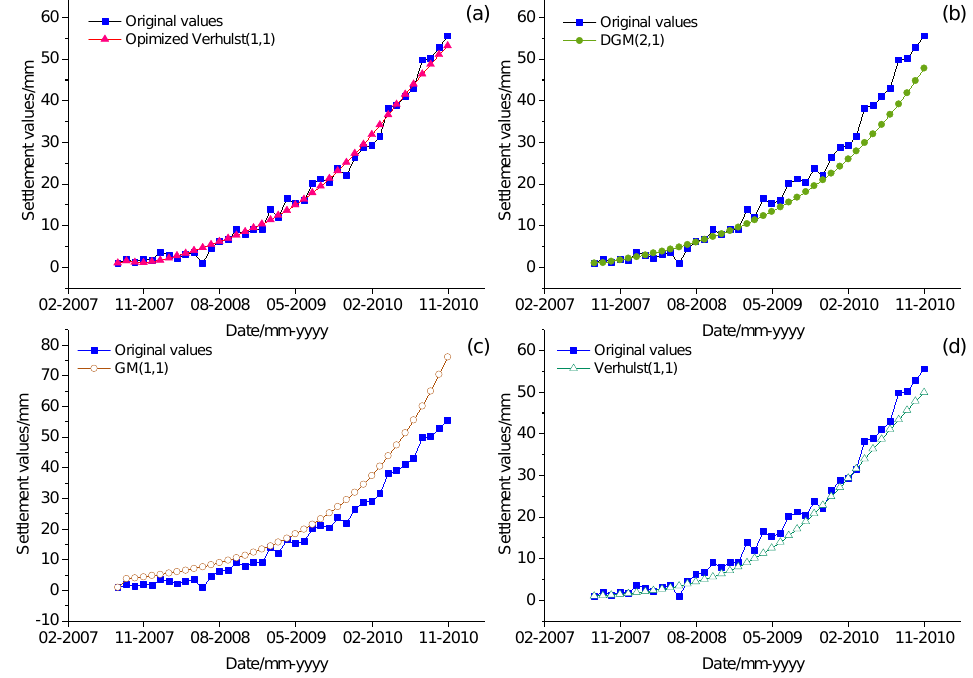
Figure 2. Comparison between measured values and fitted values of the four model for the moni- toring point ZLD-01 from Aug-2007 to Nov-2010(first 40 training sample data). ( a ) the optimized grey Verhulst (1,1) model; ( b ) DGM (2,1) model; ( c ) the traditional GM (1,1) model; ( d ) the traditional Verhulst (1,1)